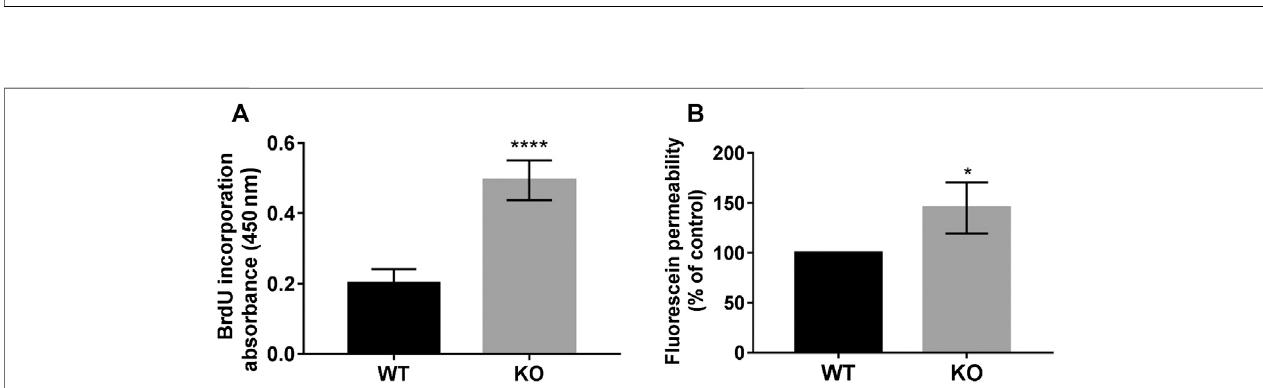
FIGURE 2 | PcdhgC3 knockout cells show increased proliferation and paracellular permeability. (A) The proliferation rate of WT and KO cells was measured using BrdUELISAKitat 16 h. (B) Wild type (WT) and PcdhgC3 knockout (KO) cells weregrown in transwellsfor6 days followed bymeasuring theparacellularpermeability for fl uorescein.ParacellularpermeabilityofKOcellswasnormalizedtoWTcells,whichwassetas100%.Dataareshownasmean ± standarddeviationofthreeindependent experiments. * p < 0.05, **** p <